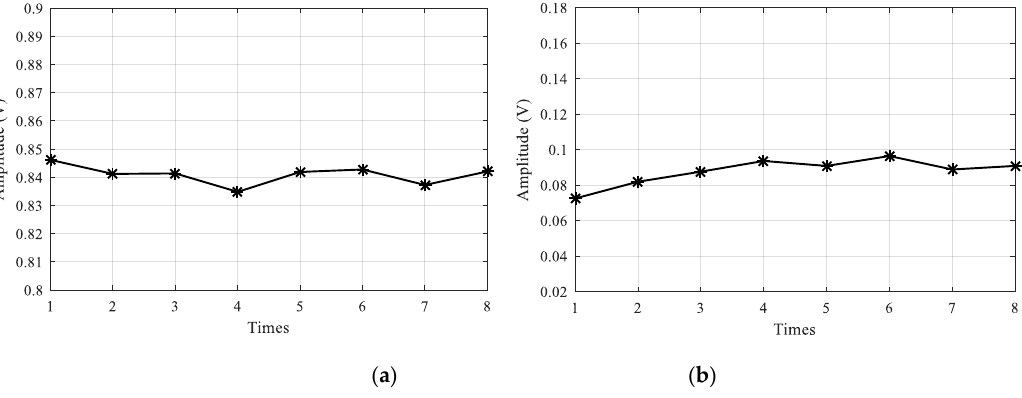
Figure 7. Amplitude plot of direct waves at different temperatures. ( a ) Low temperature – 50 °C. ( b ) High temperature 150 °C .